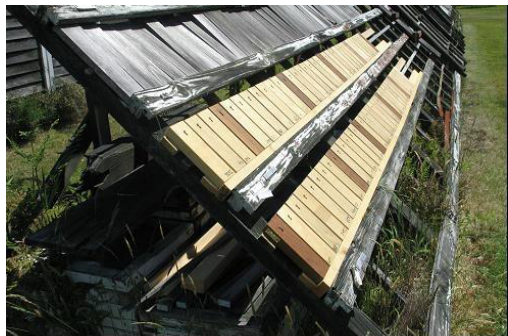
The lower L-shaped rail is untreated radiata pine. Figure 4. Flat panel test after installation. The upper rail holding the screws is H3-treated radiata